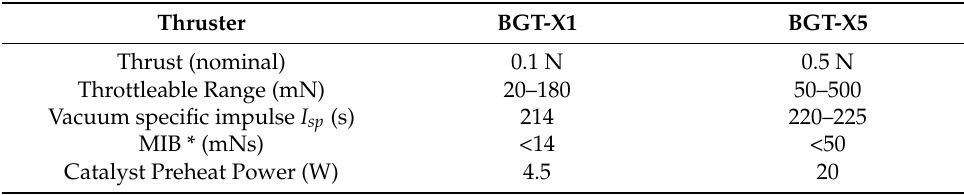
Table 14. Busek BGT thrusters: performance and specifications